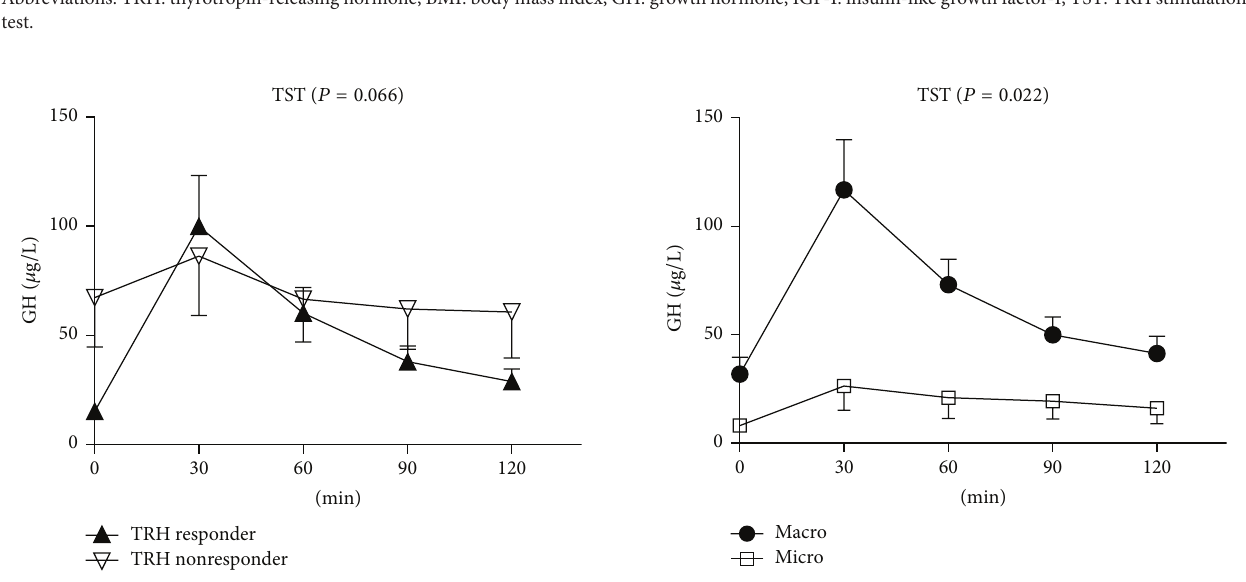
Figure 2: Comparison of GH levels between macroadenomas and microadenomas during the TST. Data represent mean ± standard error. RMANOVA was used for the statistical comparison, and Greenhouse-Geisser correction was applied if compound symmetry was not satisfied based upon Mauchly’s sphericity test. Abbre- viations: GH: growth hormone; TRH: thyrotropin releasing hor- mone; TST: TRH stimulation test; macro: macroadenoma; micro: microadenoma; RMANOVA: repeated measure one-way analysis of